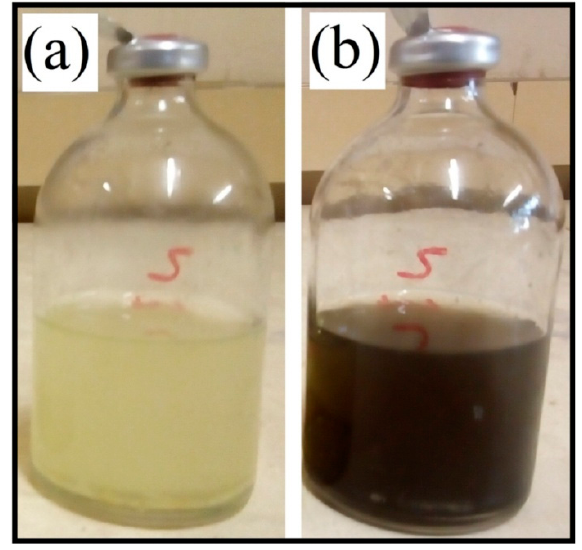
Figure 7. Visual representation of the synthesis of biogenic Pd nanoparticles (Bio-PdNPs) ( a ) before ( b ) and after Bio-PdNPs formation.